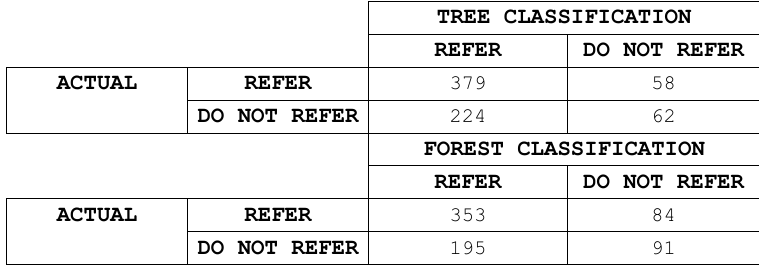
Table 11. One color slope value results.